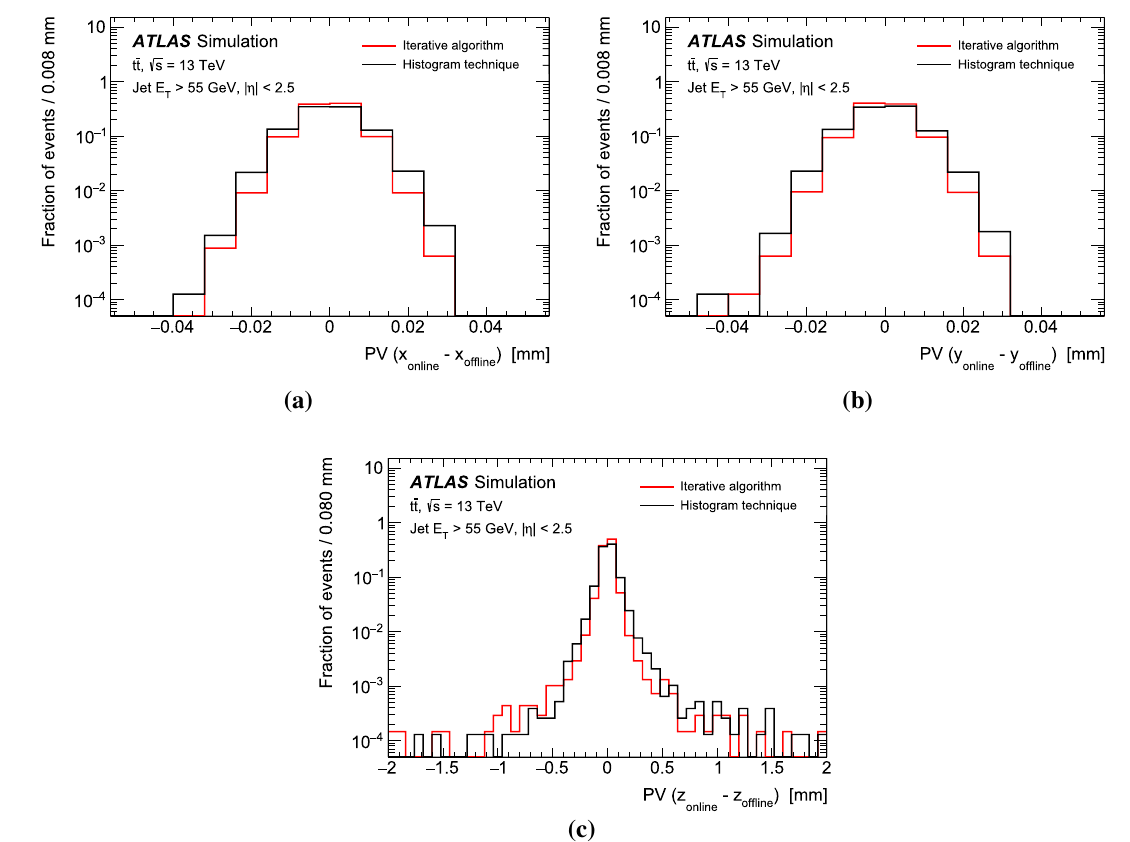
Fig. 4 Comparison of the difference between the online and offline primary-vertex positions in the a x , b y , and c z directions when using the histogramming approach and the iterative primary-vertex-finding algorithm in the b -jet trigger. Selected events must pass a trigger requir-